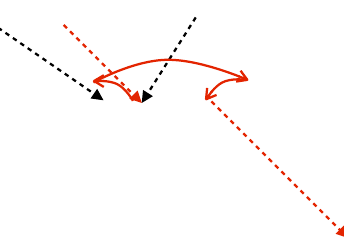
Figure 17: In a flea-gas jump trajectory, another particle is met. A second jump must then be executed, before finishing the first one. Here all scattering shifts are